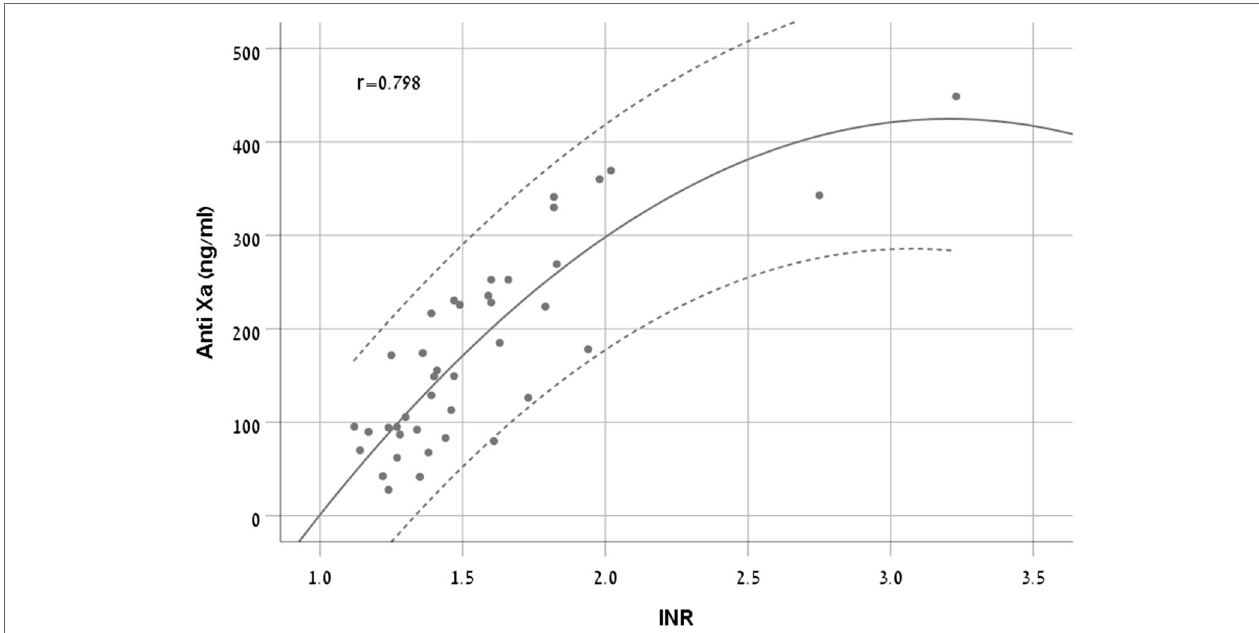
FIGURE 4 | A scatter plot demonstrating the new equation with 95% CI in patients treated with